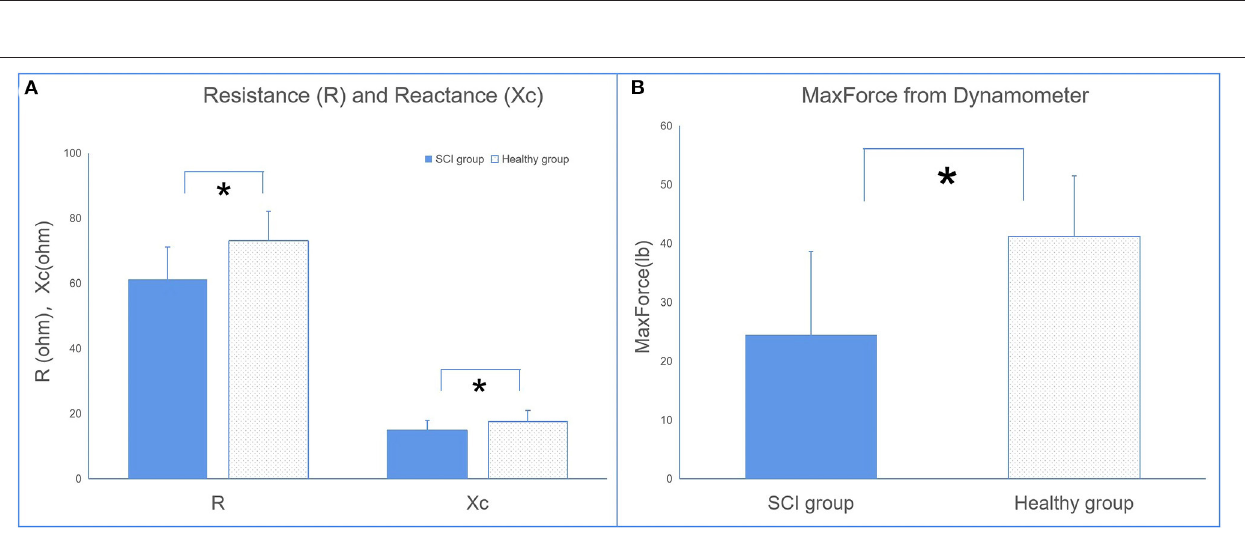
FIGURE 3 | The comparisons of electrical impedance myography (EIM) (A) and dynamometer (B) parameters between the SCI and control groups (* p < 0.05 between groups).